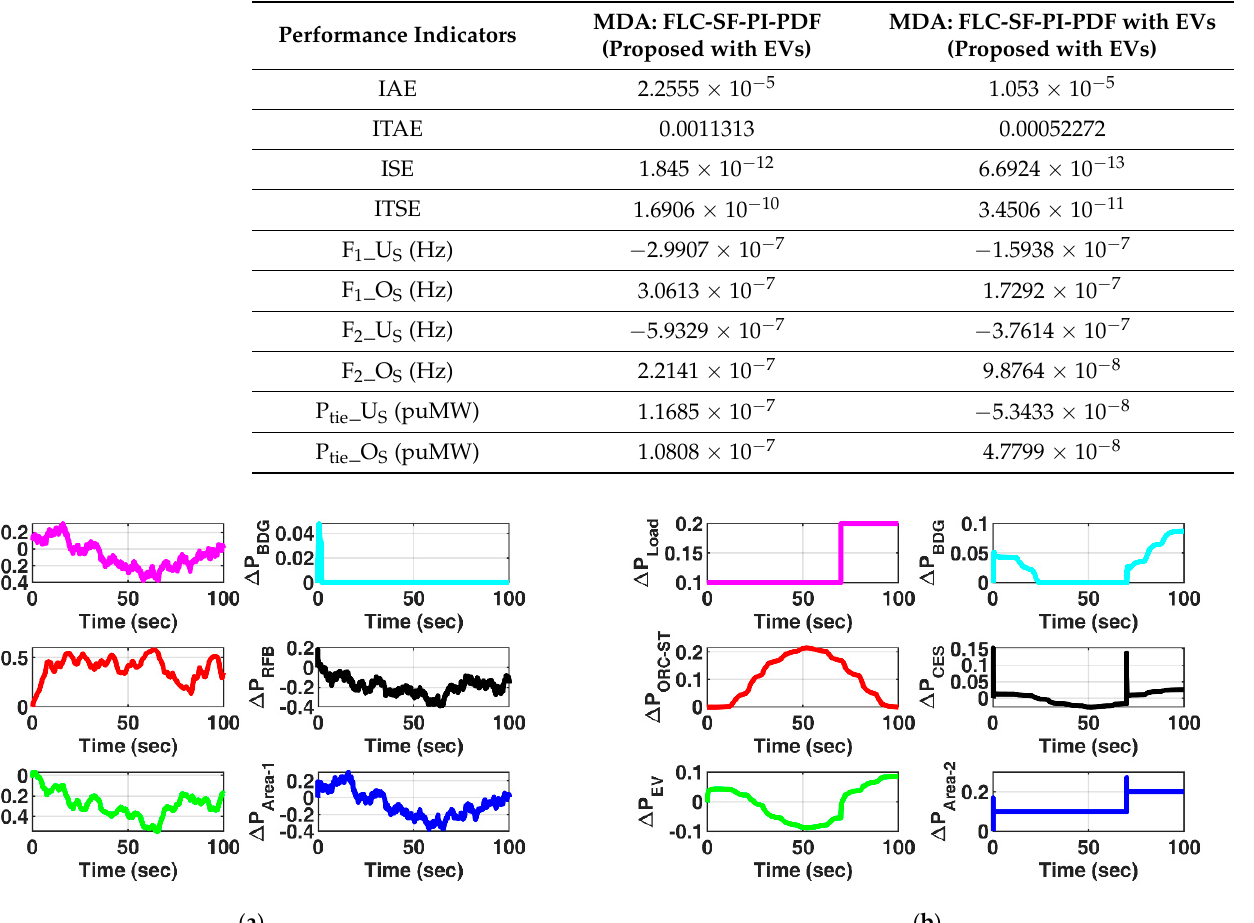
Table 4. Performance indices with random load and inputs of renewable sources input variation.